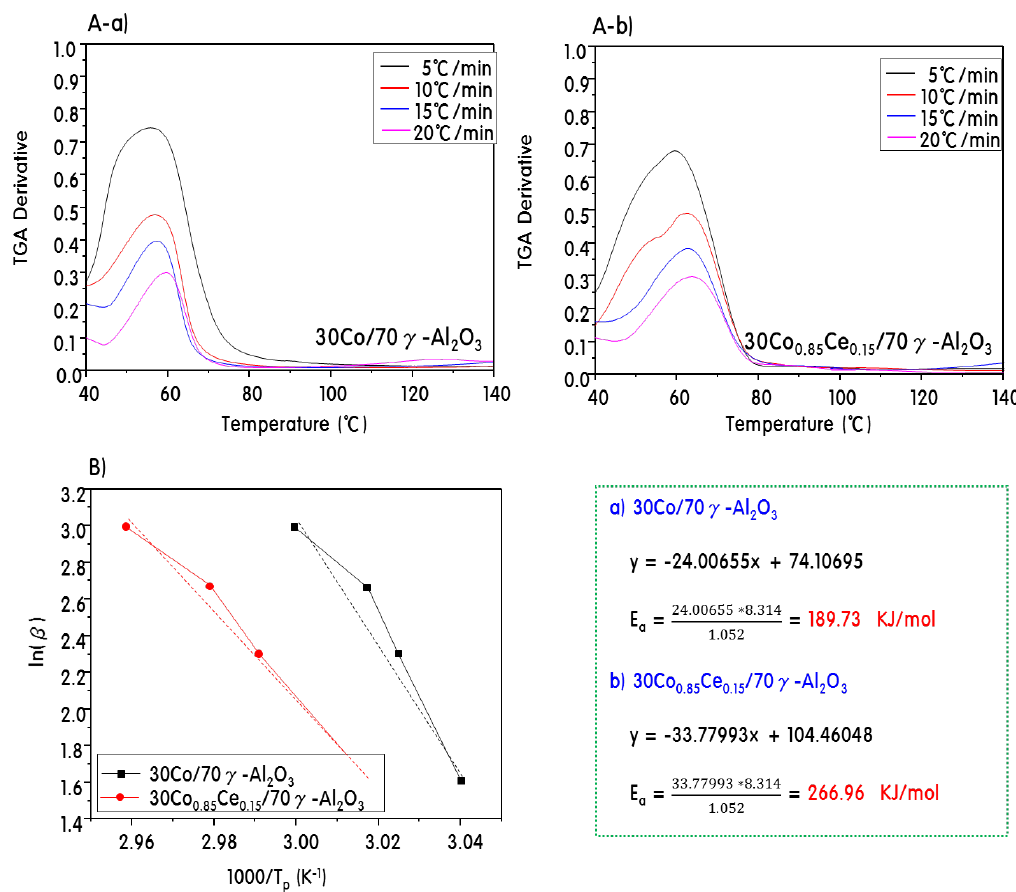
Figure 6. TGA curves ( A ) for H 2 O-desorption and the activation energies ( B ) calculated from Ozawa plots for the 30Co/70 γ -Al 2 O 3 and 30Co .85 Ce 0.15 /70 γ -Al 2 O 3 catalysts.